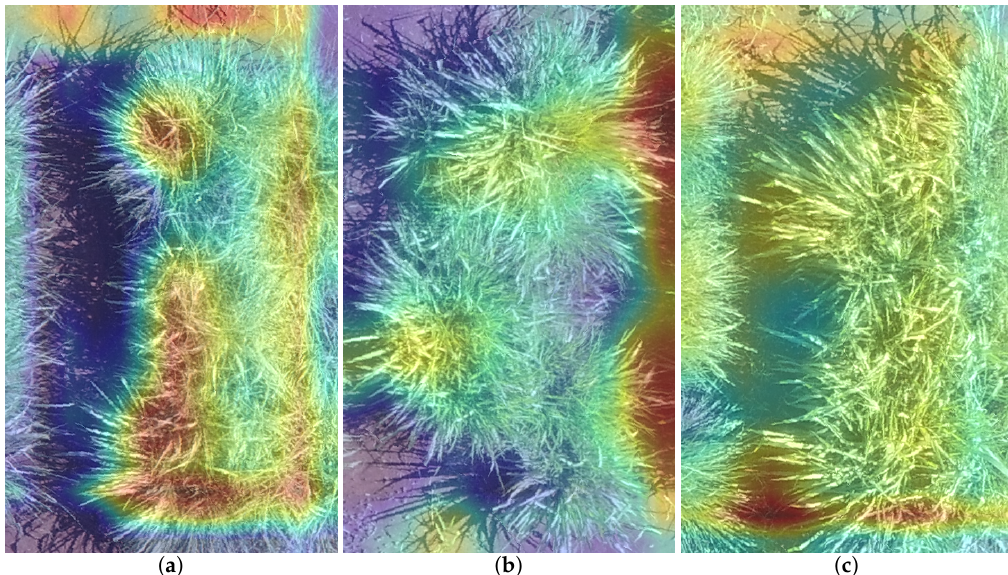
Figure 10. Heatmaps of the top 3 worst predictions made by Experiment #9 (Pre-trained AlexNet Model with hv data augmentation): ( a ) First worst prediction; ( b ) Second worst prediction; ( c ) Third worst